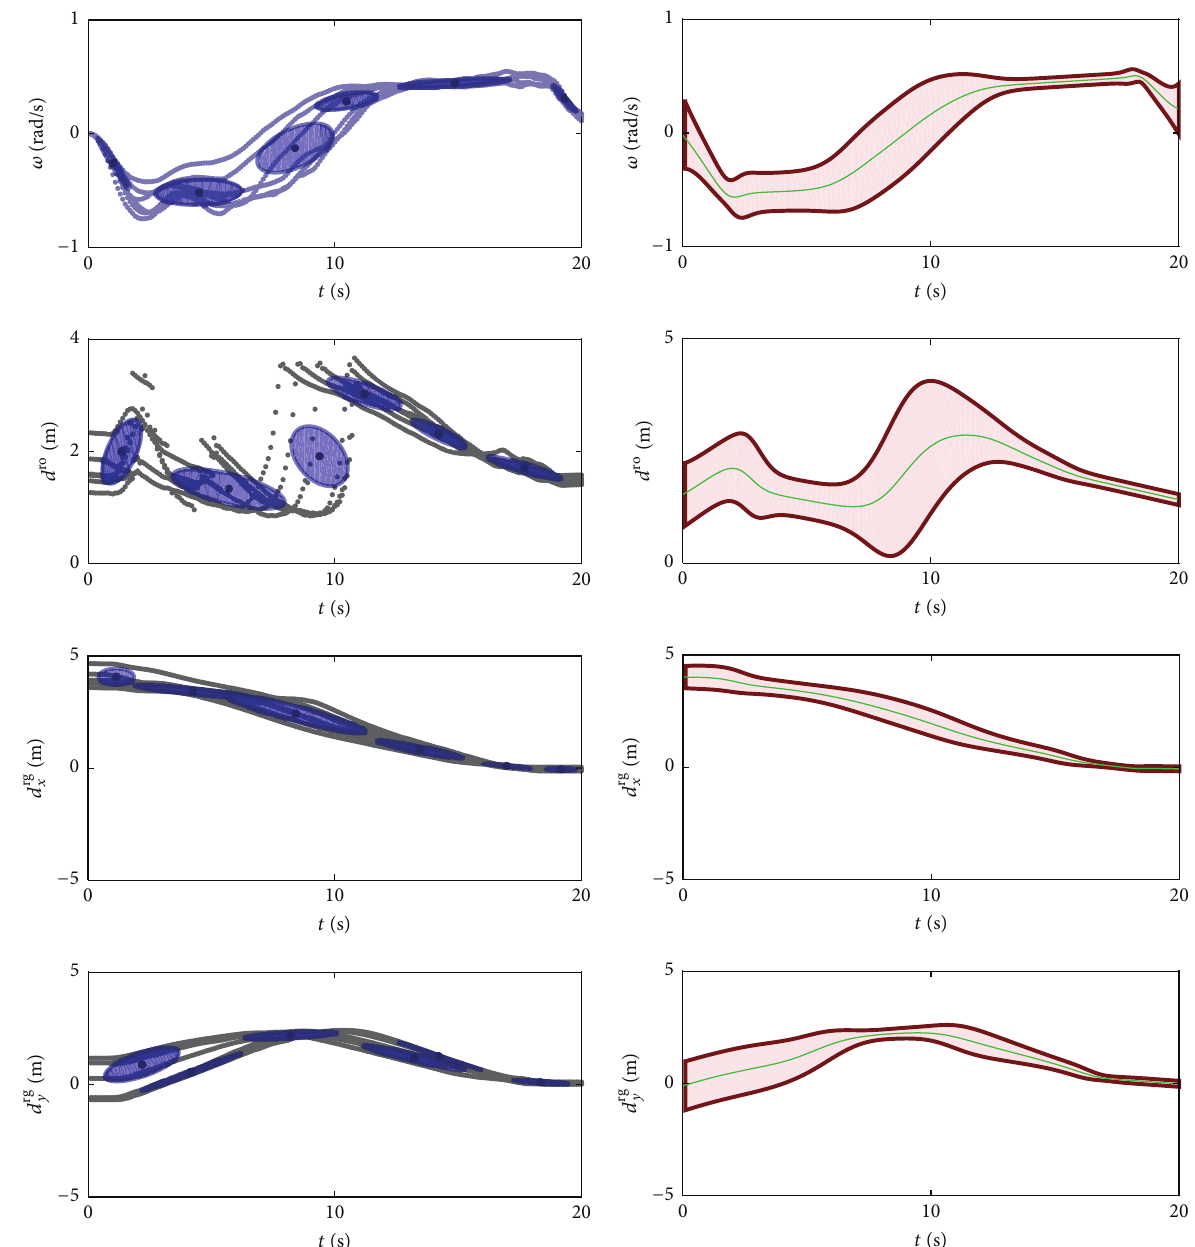
Figure 8: Encoding and retrieval for orientation and distance information in task 1, sharing the same meaning with charts in Figure 7.